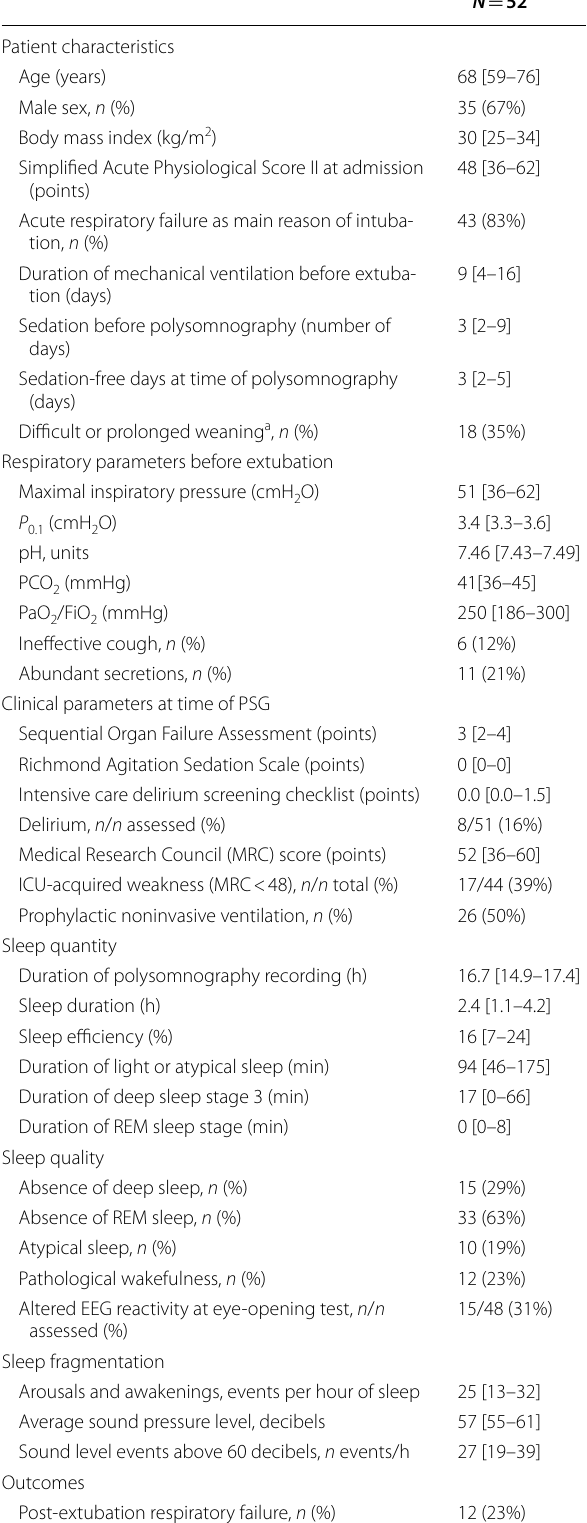
Table 1 Characteristics, sleep quality and outcomes of the 52 patients included in the